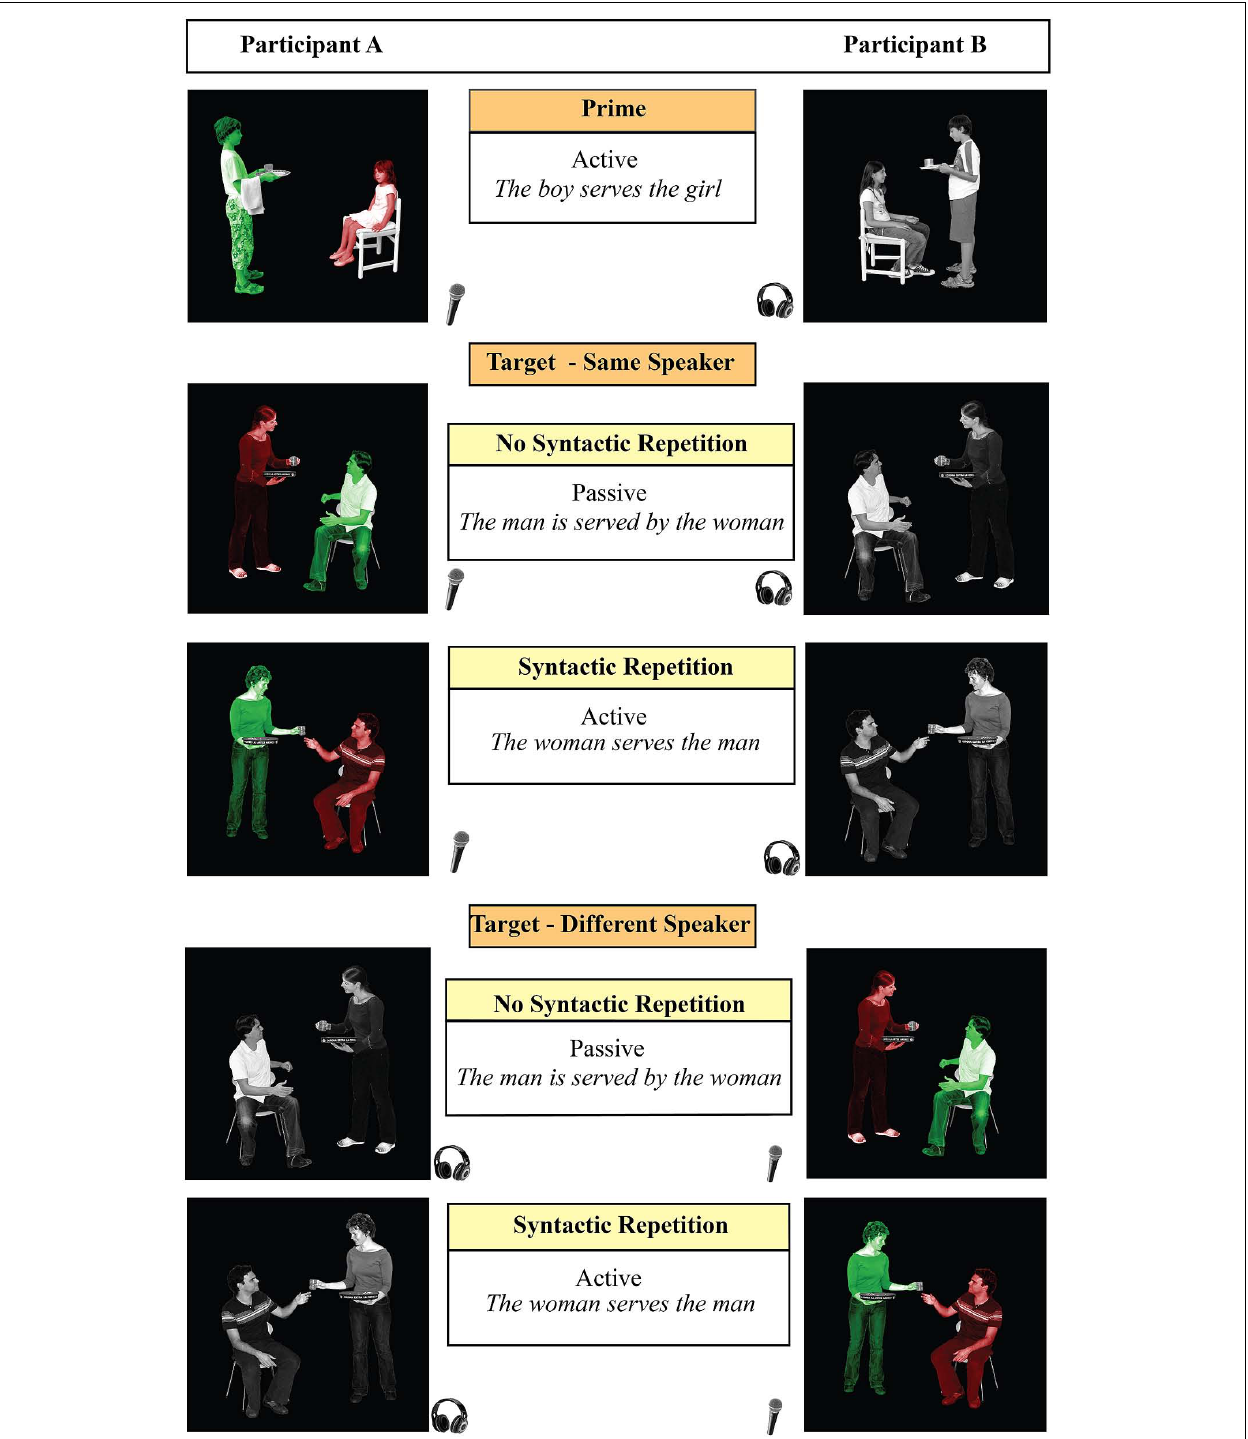
FIGURE 2 |The design figure illustrates the within-subject factors. Communicative context was manipulated between subjects (in the communi- cative context, participants A and B speak and listen to each other; in the non-communicative context, there is only one participant). Four within- participant factors are manipulated for each level of the between-participant factor context: Syntactic Repetition (repeated or novel syntax), Speaker Switch (same speaker or different speaker),Target Modality (production or